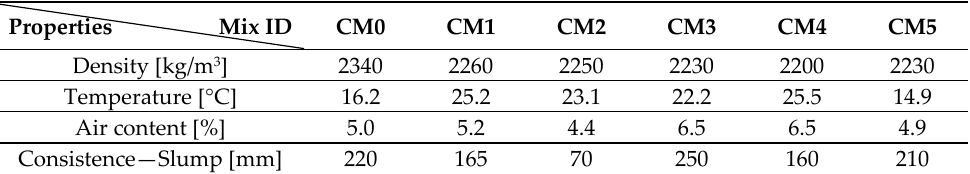
Table 7. Properties of concrete mixtures in fresh state.